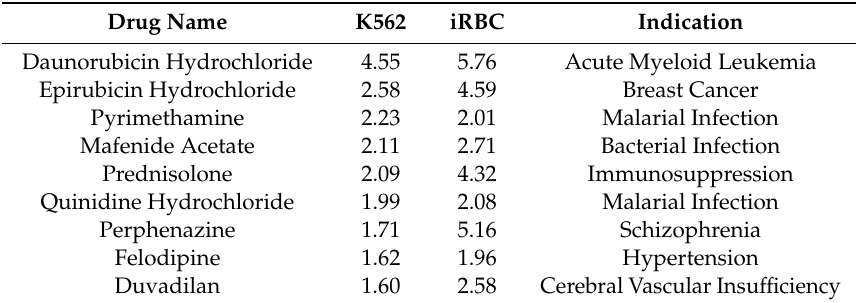
Table 1. Top 20 FDA-approved drugs that positively modulate HbF in K562 s.